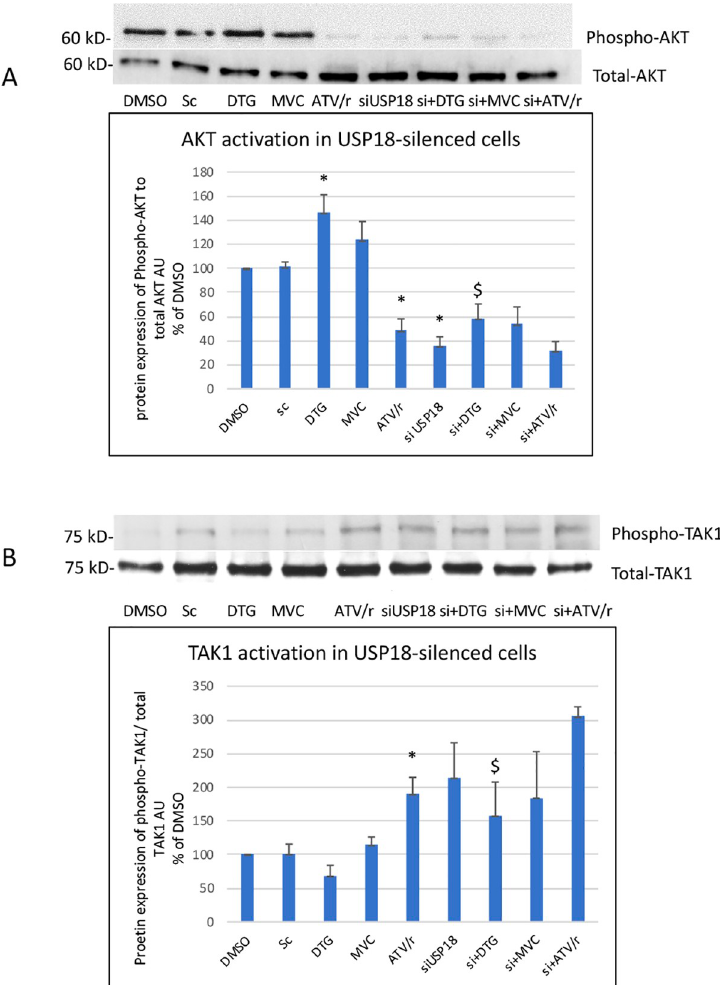
Fig 11. Effect of USP18 silencing on the ability of DTG, MVC and ATV/r to modulate basal activity of AKT (A) and TAK-1 (B) involved in insulin signaling/resistance. Representative Western blots of phospho-AKT and total AKT in A and phospho-TAK1 and total TAK-1 in B are shown. The histograms represent the mean+/-SEM value as compared to the DMSO control set at 100% of 3 independent experiments. Si-DMSO: control silenced for USP18, Si- DTG: DTG-treated cells silenced for USP18, Si-MVC: MVC-treated cells silenced for USP18, Si-ATV/r: ATV/r-treated cells silenced for USP18. The comparisons used Welch’s correction of Student T-test. � p < 0.05, �� p < 0.01 versus control